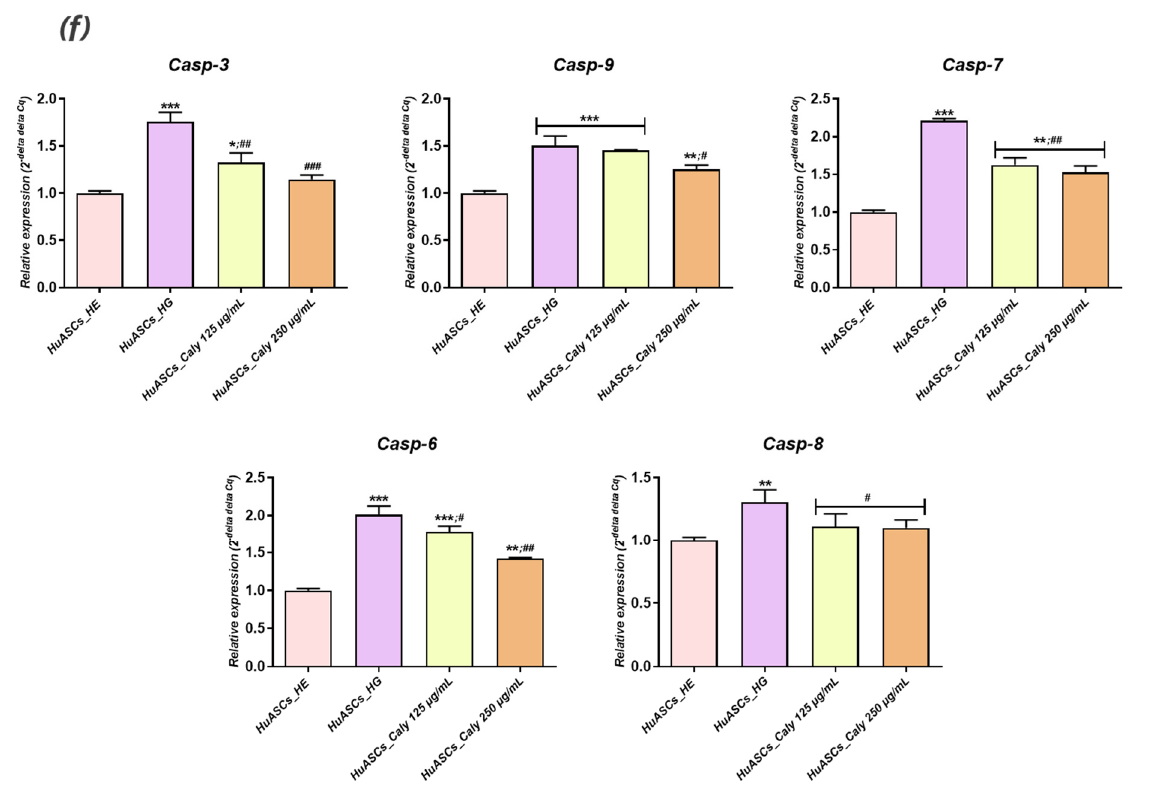
Figure 3. Pro-survival effect of total calystegine extract on HuASCs cells cultured under hyperglycemic conditions. ( a ) Histograms depicting the average absorbance at 600 nm of the metabolised Resazurin dye. ( b ) Average absorbances of incorporated BrdU into newly synthesised DNA of treated HuASCs cells. ( c ) Representative apoptosis dot plots from flow cytometry analysis. ( d ) Quantitative estimation of Annexin V/7-AAD positive and negative cells. ( e ) Relative gene expression quantitation of main apoptosis–associated marker levels. ( f ) Relative gene expression representation of different caspase transcripts. Representative data from three independent experiments are shown ± SD (n = 3). An asterisk (*) indicates a comparison of the HG group to untreated healthy cells. A hashtag (#) indicates a comparison of the HG group pre-treated with calystegines to the HG untreated healthy cells. */# p < 0.05, **/## p < 0.01, ***/### p < 0.001. HuASCs_HE: human ASCs healthy untreated cells; HuASCs_HG: Hyperglycaemic human ASCs cells exposed to a high concentration of glucose. HuASCs_Caly 125 µg/mL: Hyperglycaemic human ASCs cells pre-treated with 125 µg/mL calystegines extracted and exposed to a high concentration of glucose. HuASCs_Caly 250 µ g/mL: Hyperglycaemic human ASCs cells pre-treated with 250 µ g/mL calystegines extracted and exposed to a high concentration of